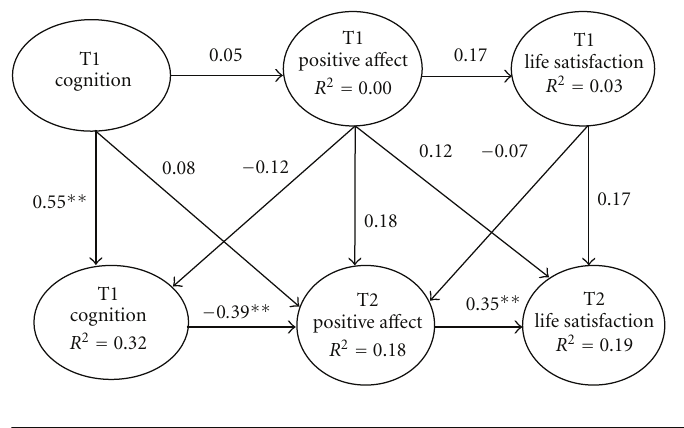
Figure 2: Positive a ff ect model of life satisfaction among centenarians at Time 1 ( N = 136) to Time 2 ( N = 68). Note. ∗∗ P < . 01. words, the greater positive emotions appear to diminish the deleterious influence of cognitive impairment on life satisfaction among persons living 100 years and